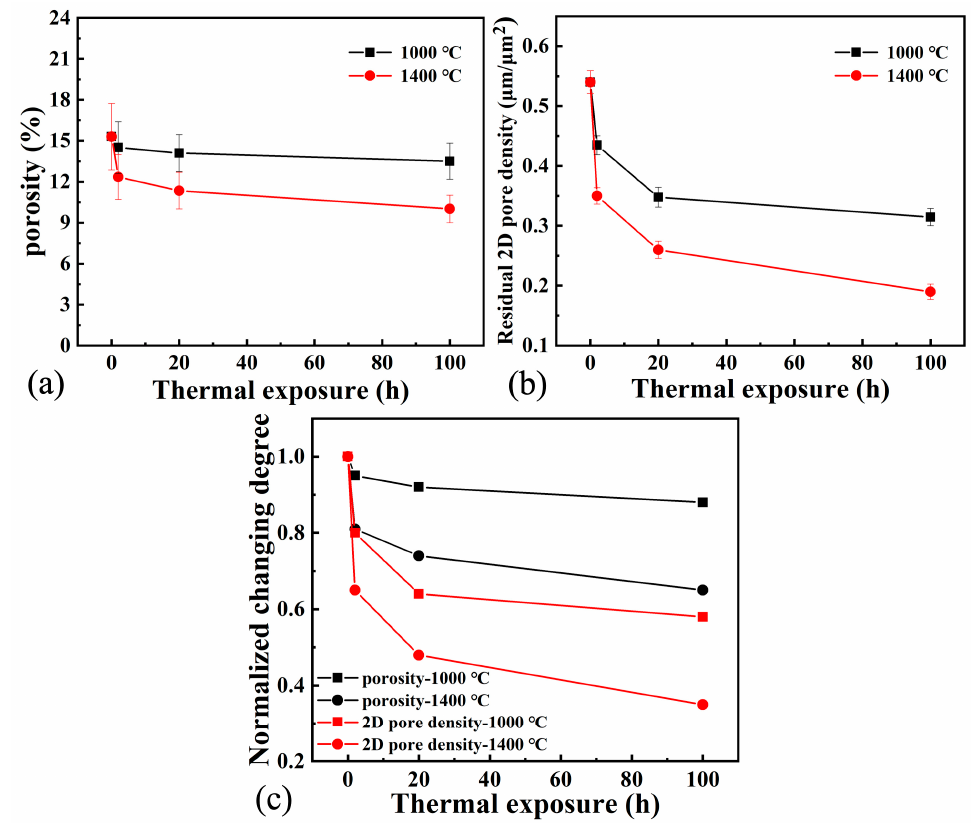
Figure 6. Changes in ( a ) porosity and ( b ) 2D pore density of TBCs with thermal exposure durations. ( c ) Changing degree of normalized porosity and 2D pore density with thermal exposure.